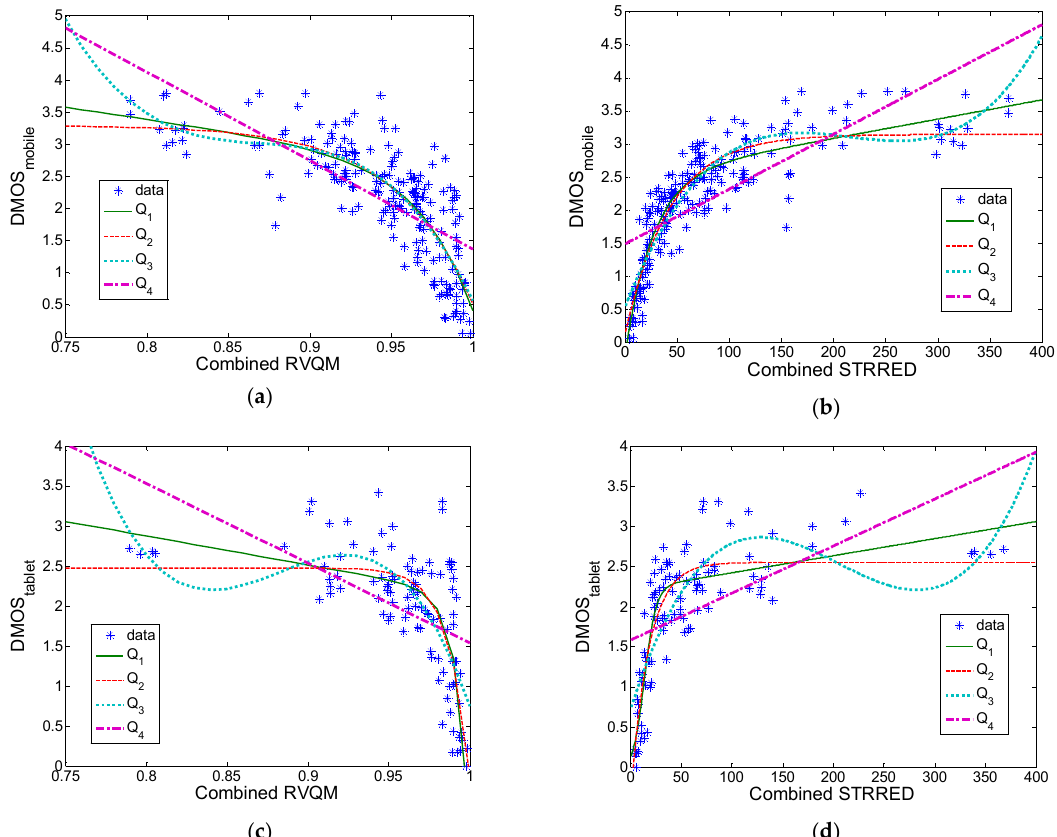
Figure 5. Combined objective measure: ( a ) RVQM (reduced video quality measure), mobile dataset; ( b ) STRRED (spatio-temporal reduced reference entropic differences), mobile dataset; ( c ) RVQM, tablet dataset; ( d ) STRRED, tablet dataset.